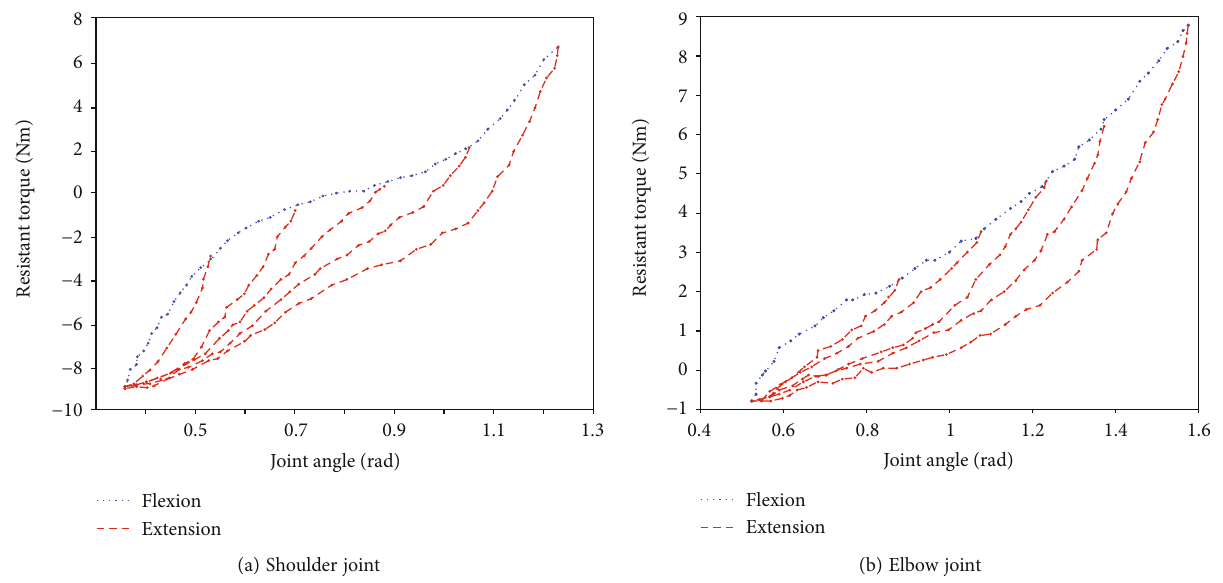
Figure 2: The fi rst-order transition curves of upper limb